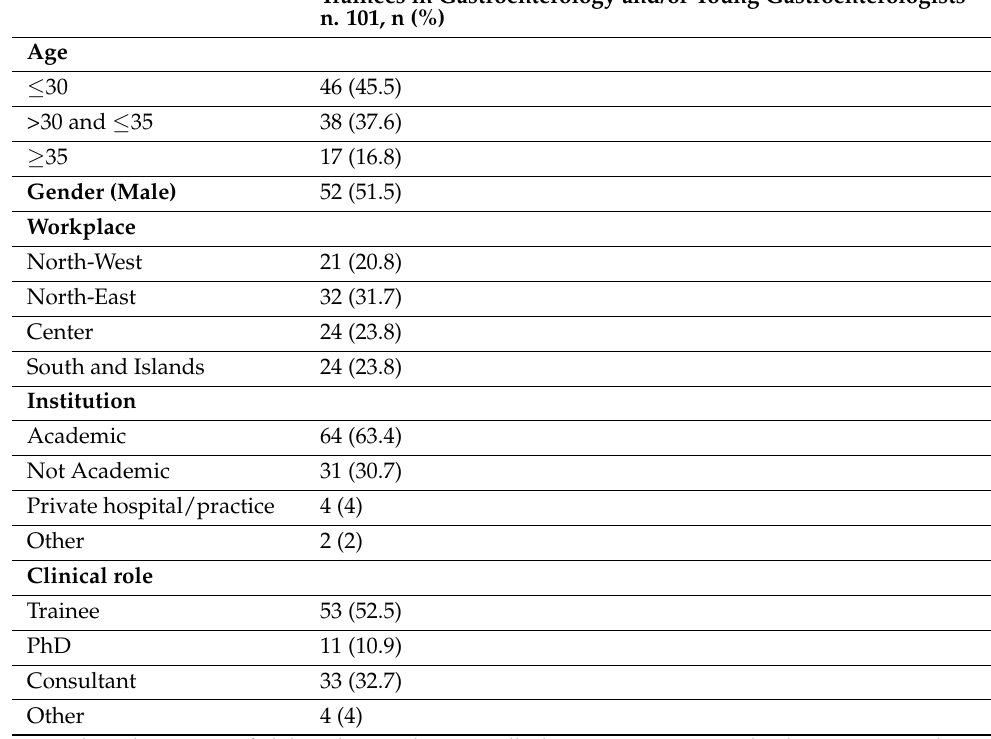
Table 1. Demographic data of trainees in gastroenterology and/or young gastroenterologists accept- ing to participate in the